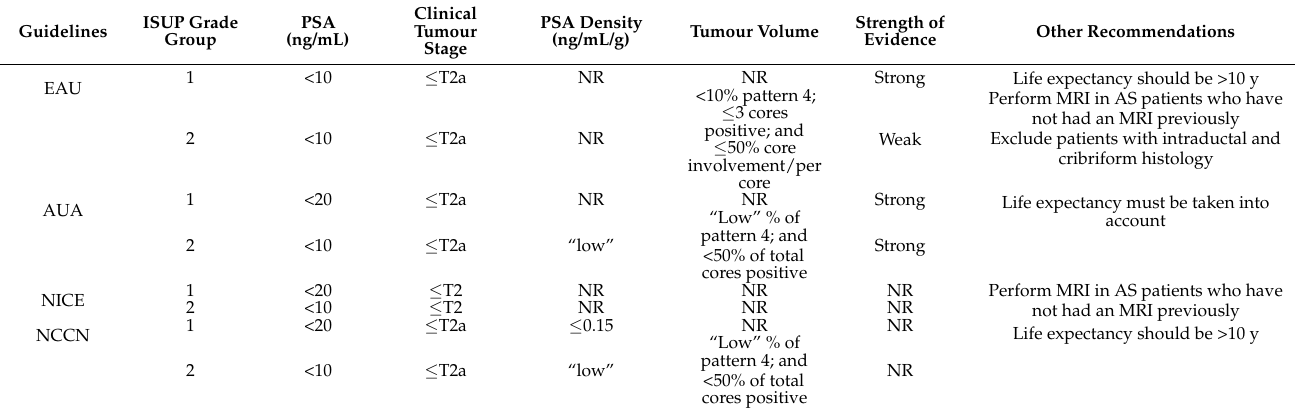
Table 2. Current guideline recommendations on active